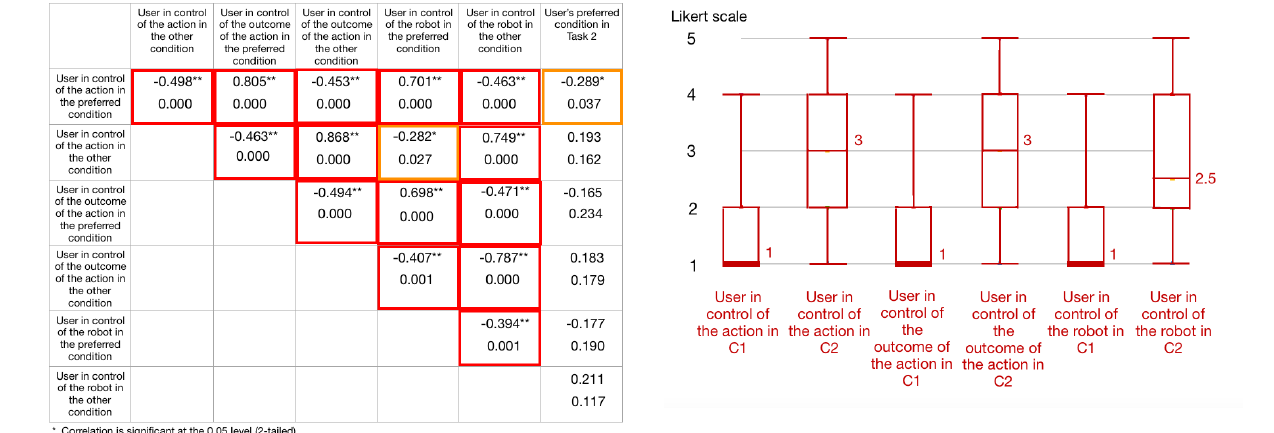
Figure 14: Task 3: doing a dance.